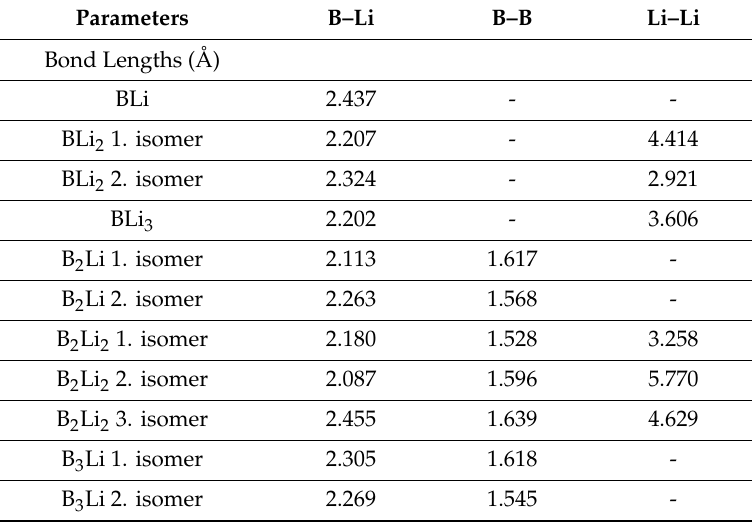
Table 1. Average Bond Lengths of the B x Li y clusters.